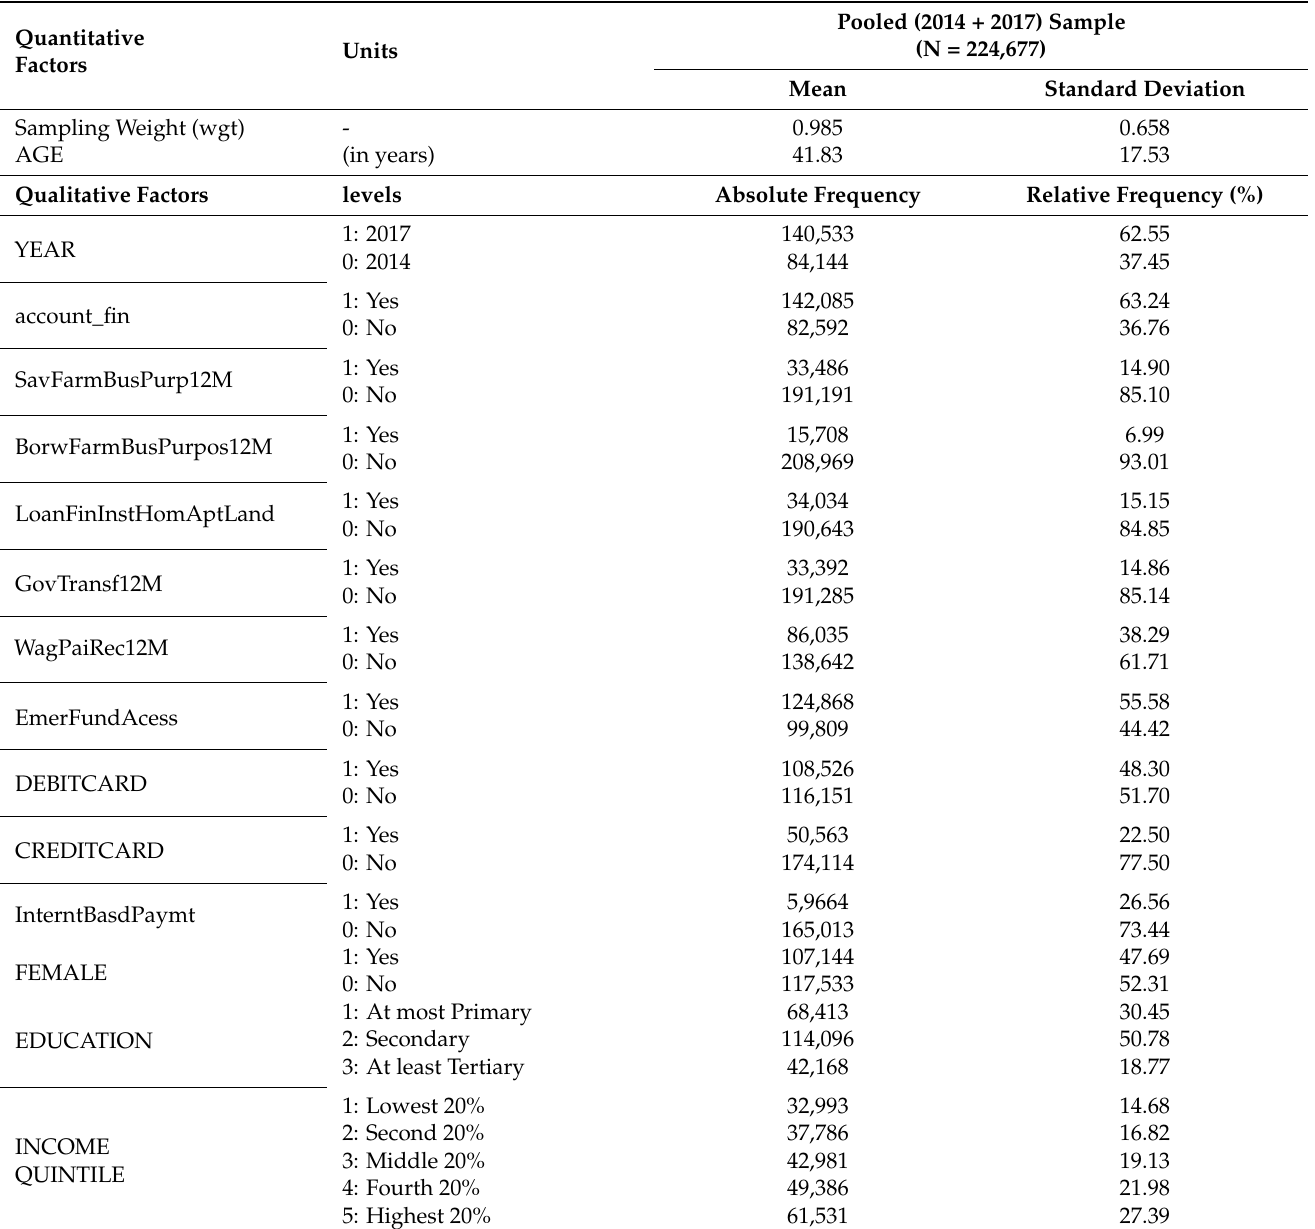
Table A2. Quantitative summary description of the study